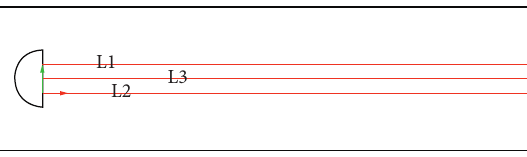
Figure 5: View of horizontal lines.